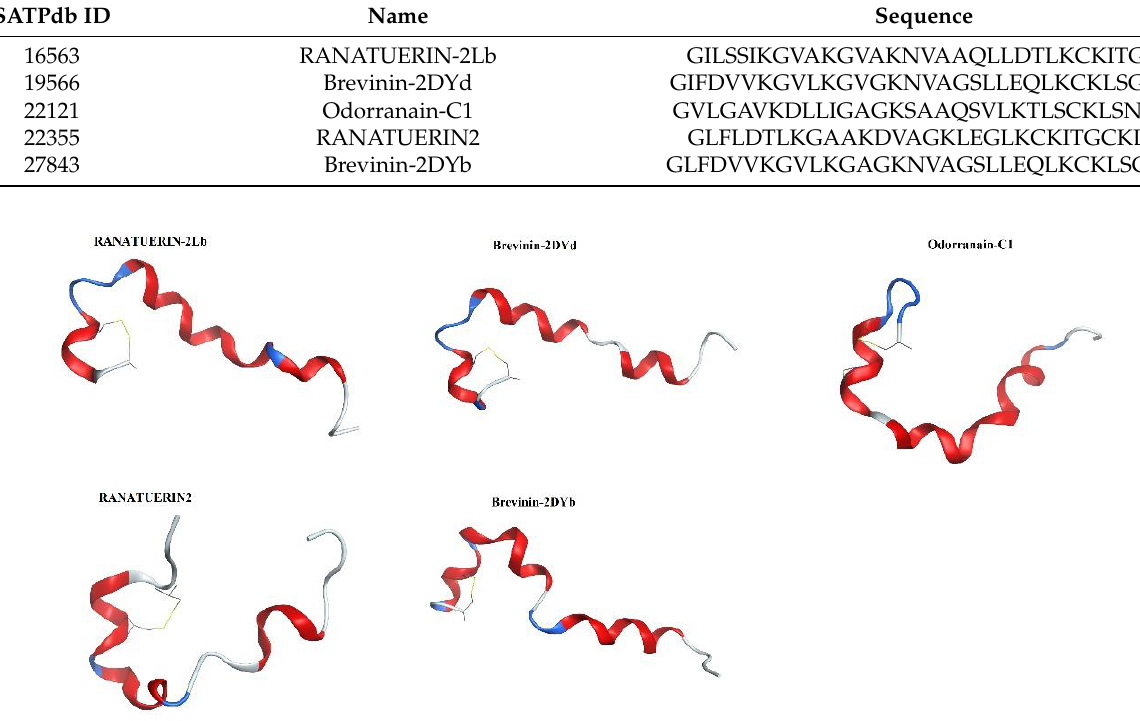
Figure 5. Three-dimensional structure of 5 candidate ACPs.